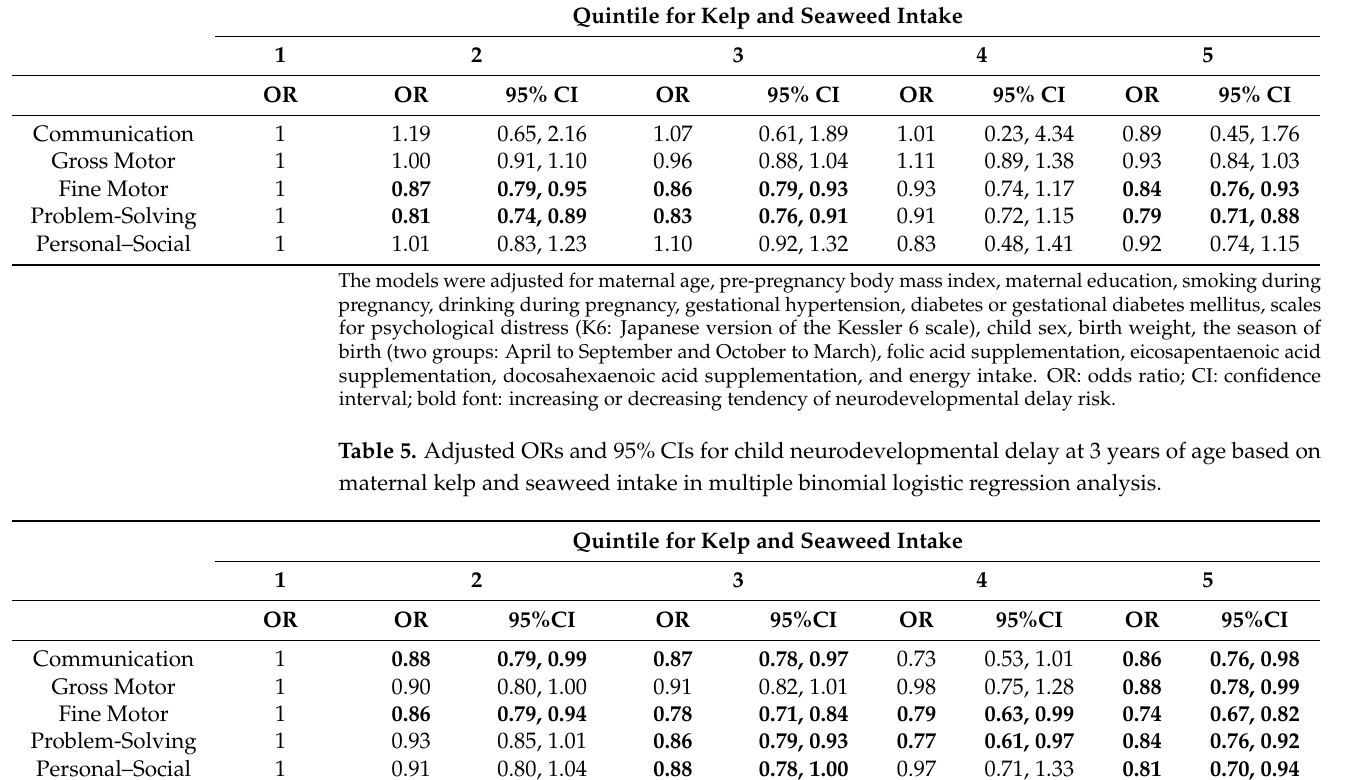
Table 4. Adjusted ORs and 95% CIs for child neurodevelopmental delay at 1 year of age based on maternal kelp and seaweed intake in multiple binomial logistic regression analysis. Quintile for Kelp and Seaweed Intake